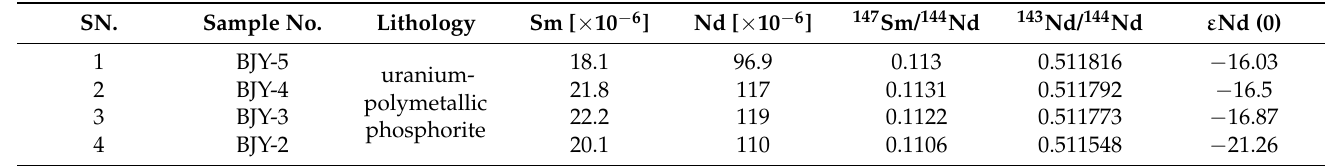
Table 4. The Sm-Nd isotopic composition of the samples from the Baizhuyu deposit. SN. Sample